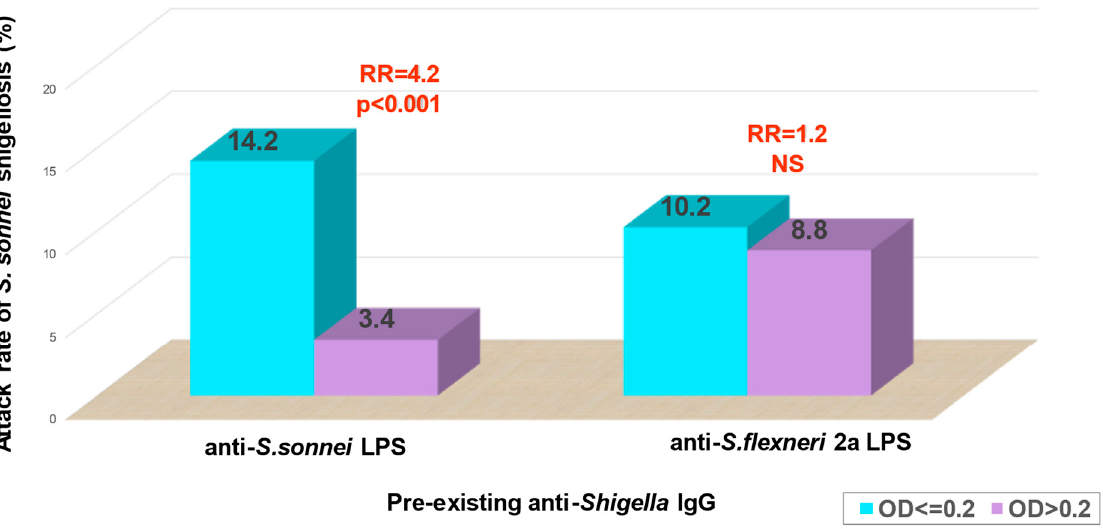
Figure 1. Pre-existing anti- S. sonnei LPS antibodies & S. sonnei shigellosis; RR= relative risk; NS = not significant; OD = Optical density; Blue bars stand for subjects with anti- S. sonnei or anti- S. flexneri LPS antibodies equal or lower than OD 0.2; Purple bars stand for subjects with anti- S. sonnei or anti- S. flexneri LPS antibodies higher than OD 0.2. Cohen D et al. J. Clin. Microbiol. 1990 [30]; J. Infect. Dis. 1992 [32].